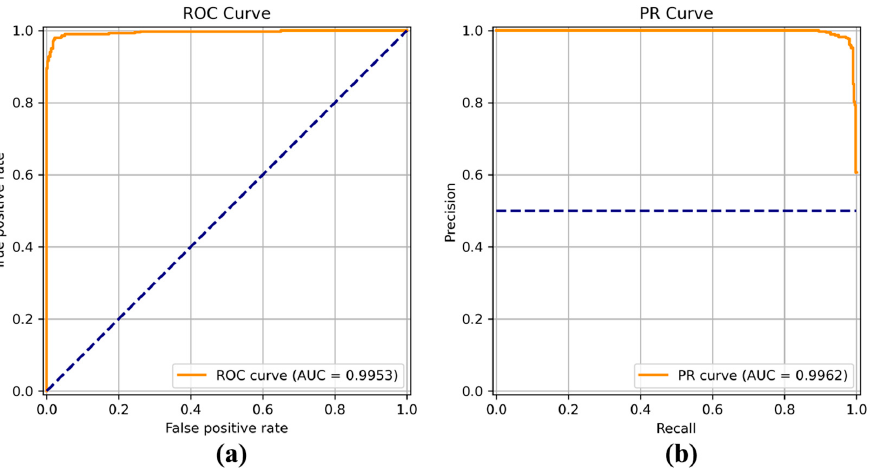
Figure 10. ( a ) Receiver operating characteristic (ROC) curve and ( b ) precision recall (PR) curve of EfficientNet.